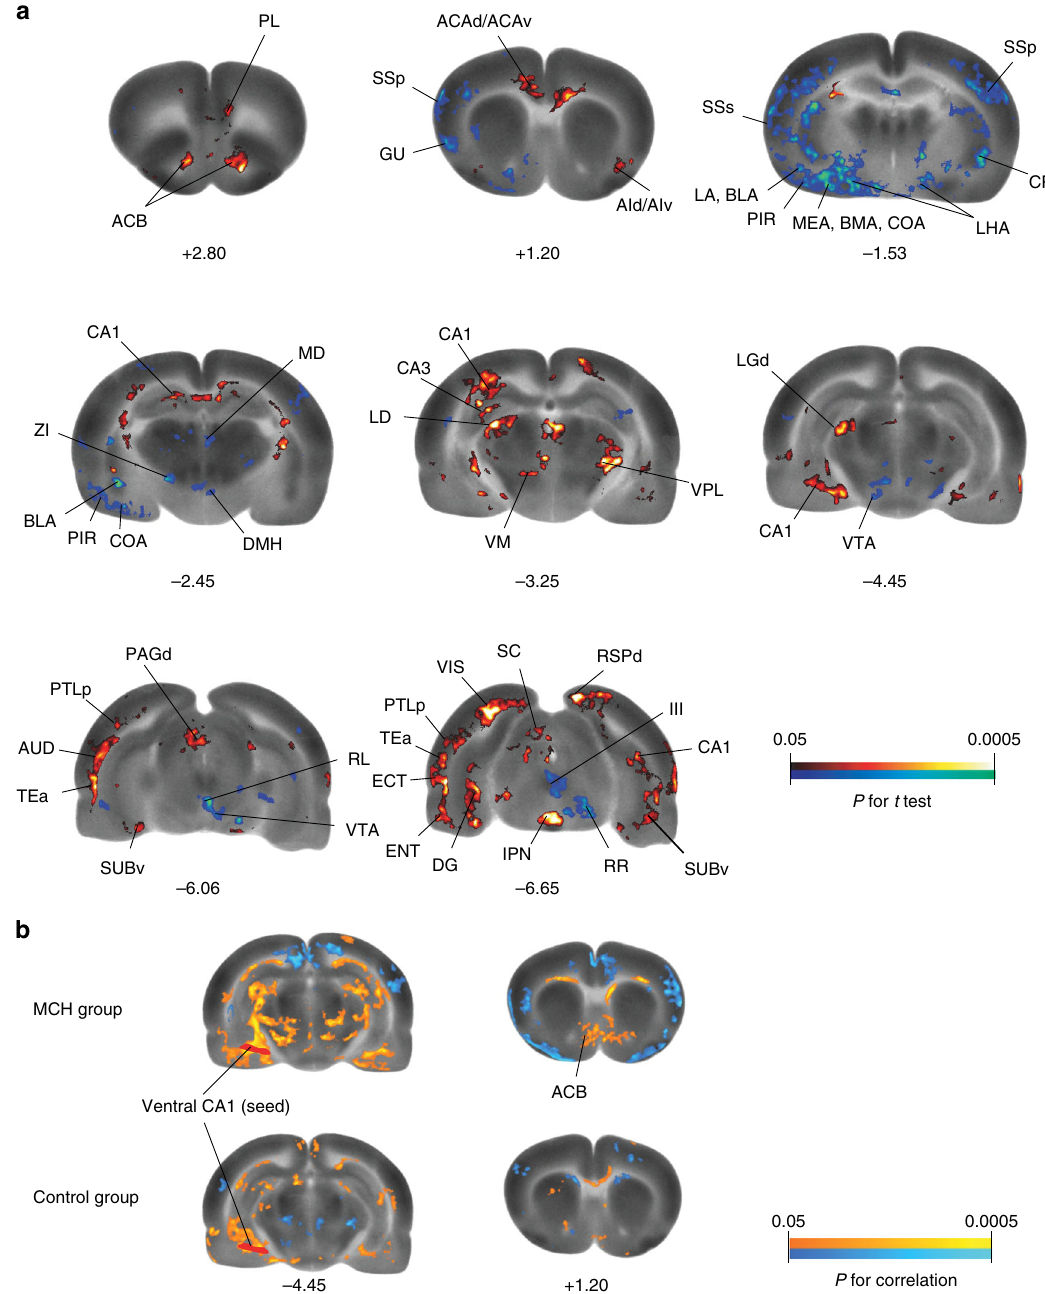
Fig. 6 Neural responses following vHP MCHR1 activation. a Color-coded overlays over a selection of representative coronal sections of the template brain show signi fi cant MCH-induced changes in regional cerebral glucose uptake (rCGU) as an indirect measurement of brain activation (Student ’ s t test, red/ blue: increase/decrease in rCGU in the MCH group compared to the control group; n = 9 and 8, respectively). Numbers under images are approximate level along the anterior – posterior axis relative to the bregma (in mm). b Seed correlation analysis revealed statistically signi fi cant positive correlation between the seed in the ventral CA1 and ACB shell area in the MCH but not in the control group (Pearson ’ s correlation, orange/blue: positive/negative correlation with the seed). ACB nucleus accumbens, ACAd/ACAv anterior cingulate area, dorsal/ventral part, AId/AIv agranular insular area, dorsal/ ventral part, AUD auditory area, TEa temporal association areas, BLA basolateral amygdalar nucleus, BMA basomedial amygdalar nucleus, CA1/CA3 CA1/ CA3 area of the HP, COA cortical amygdalar nucleus, CP caudoputamen, DG dentate gyrus, DMH dorsomedial hypothalamic nucleus, ECT ectorhinal area,